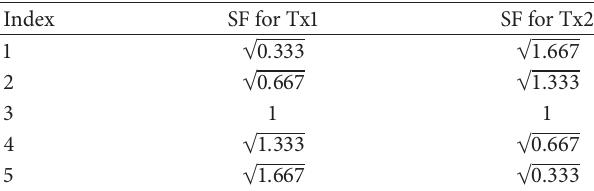
Table 1: An SF generation example for 2 × 2 PS-SM.